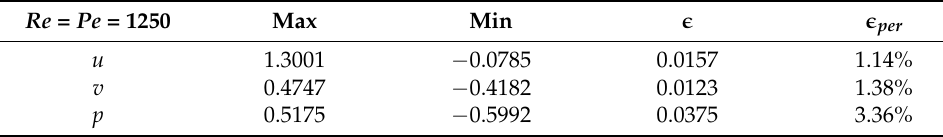
Table 5. The percentage form of error in Re = Pe = 5000.